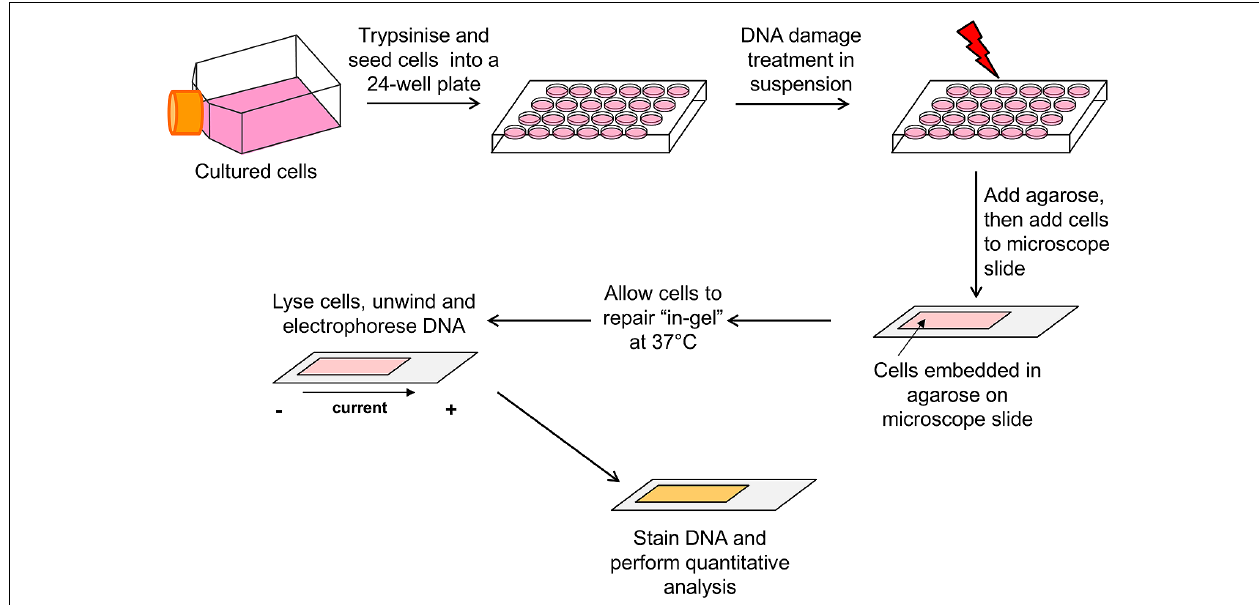
FIGURE 3 | Schematic of the in-gel DNA repair comet assay. Actively dividing cells cultured as a monolayer in flasks/dishes are trypsinized, counted, and diluted in cell culture medium ( ∼ 2 × 10 5 cells/ml). Cells (250 μ l) are aliquoted into the wells of a 24-well plate placed on ice, and then treated in suspension with the DNA damaging agent. Molten low melting point agarose (1 ml) is added to the cells, mixed, and the agarose/cell suspension immediately added to a microscope slide precoated with normal melting point agarose. A glass coverslip is added and the slide placed on ice to allow the agarose to set.The slides are then transferred to a humidified chamber prewarmed at 37 ◦ C and the cells allowed to undergo DNA damage repair for